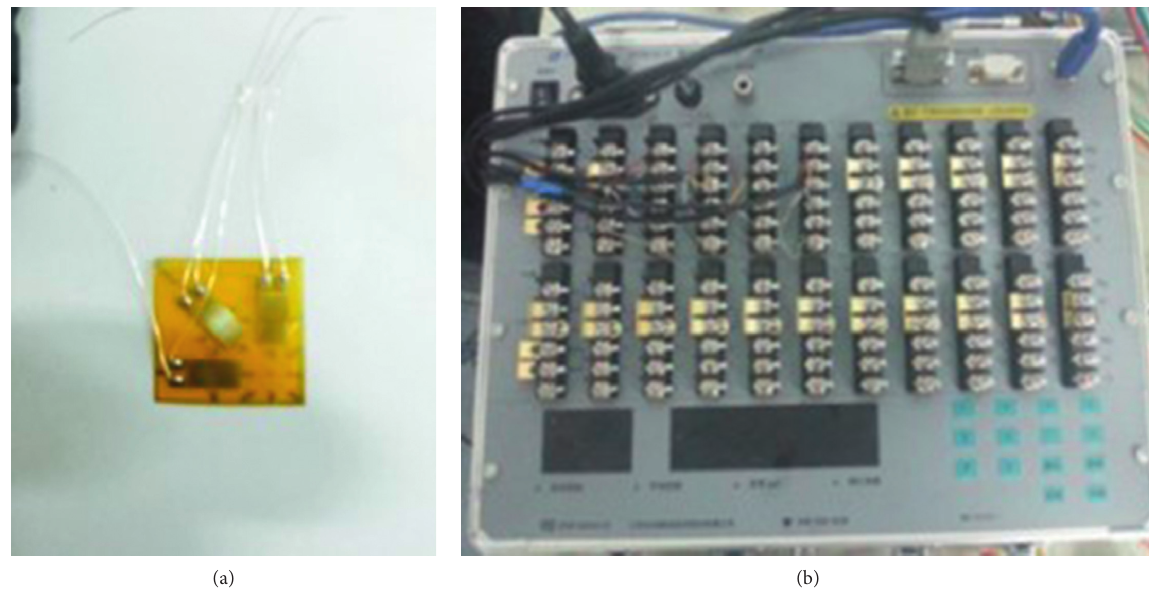
Figure 6: Strain flower and static strain gauge as used during testing. (a) Strain rosette. (b) DH-3818 strain gauge.